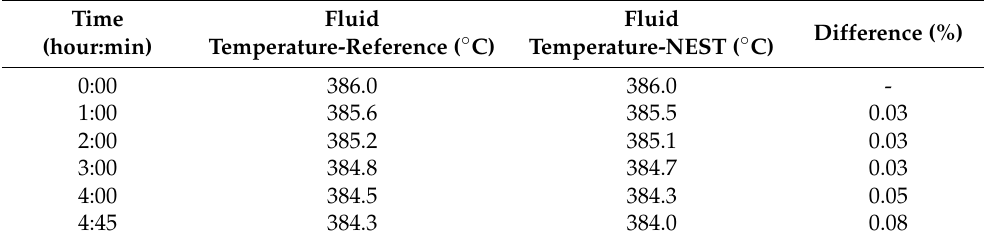
Table 4. Comparison of the behavior of the fluid temperature in the storage